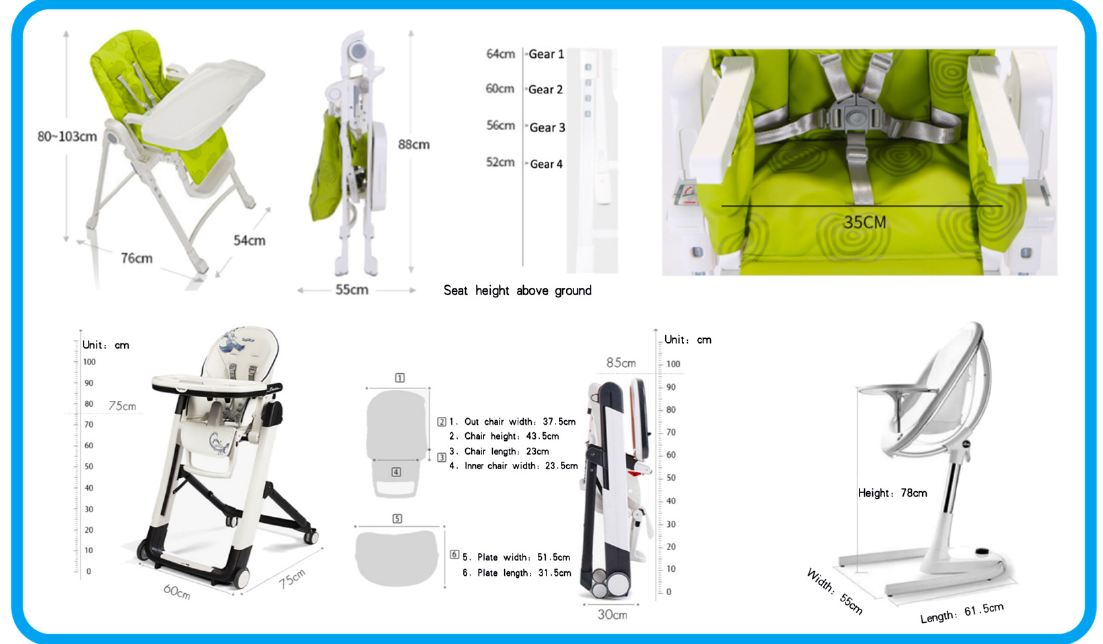
Figure 4. Standard size range of the baby chair.